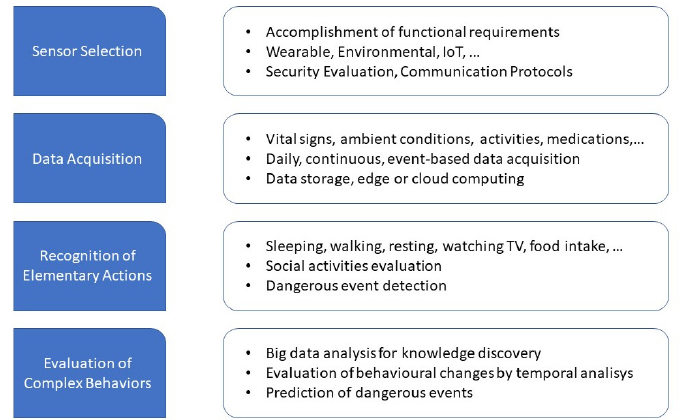
Figure 6. The main steps in AAL